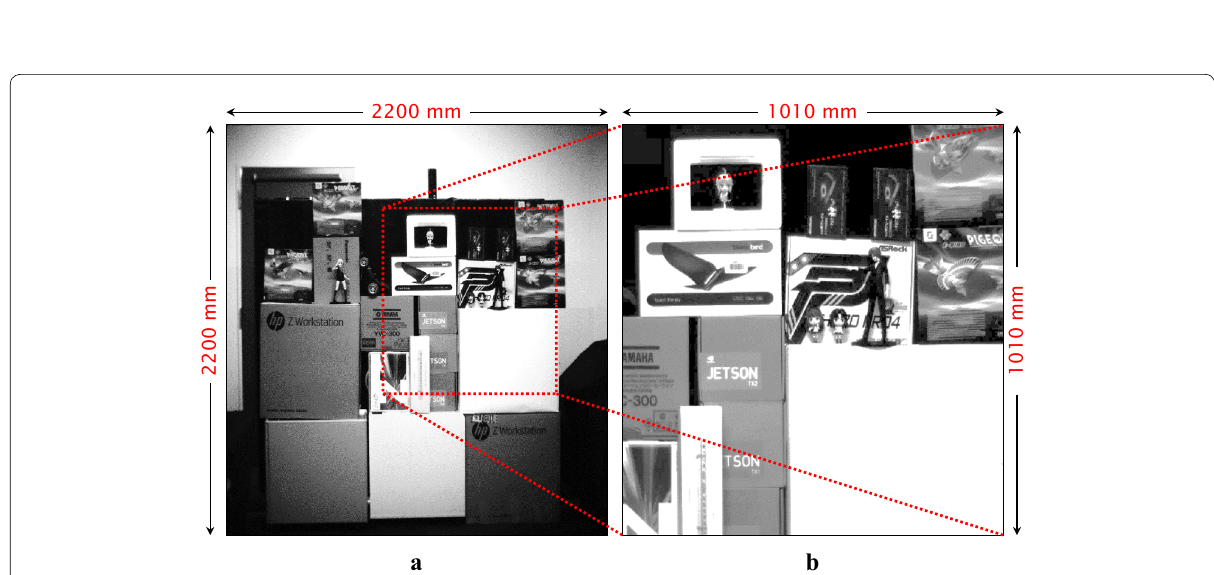
Fig. 2 Input images of patterned objects captured at a distance of 5 m a high-resolution camera (camera 2: 2048 × 2048 ), b high-speed camera (camera 1: 512 × 512